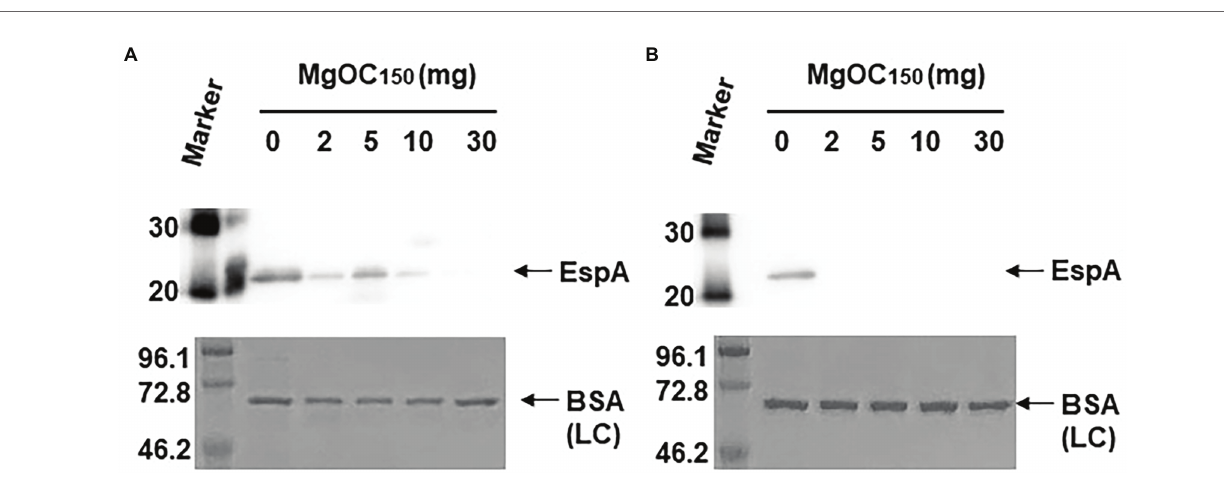
FIGURE 4 | Determination of EspA levels. (A) EspA levels in the EHEC supernatant cultured with and without MgOC 150 . (B) The EHEC supernatant was incubated with and without MgOC 150 for 2 h, and EspA levels were estimated after MgOC 150 removal. Proteins including EspA were separated by SDS-PAGE. EspA was visualized by Western blotting with EspA antiserum. For loading control (LC), BSA was visualized by CBB stain. Locations of molecular mass standards (in kilodaltons) are shown on the